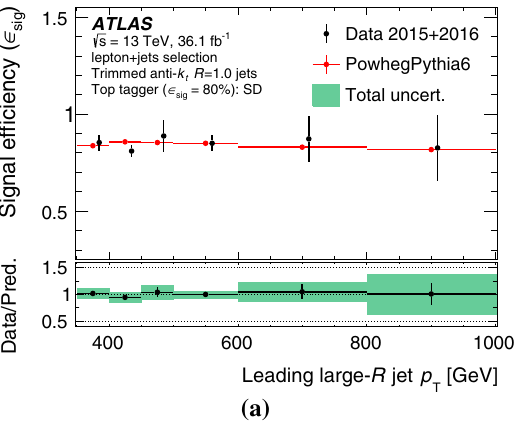
that estimated in Monte Carlo is shown with statistical uncertainties as error bars on the data points and the sum in quadrature of statistical and systematic uncertainties as a shaded band. When considering experi- mental uncertainties arising from the large- R jet, only those coming from the jet energy scale and resolution are